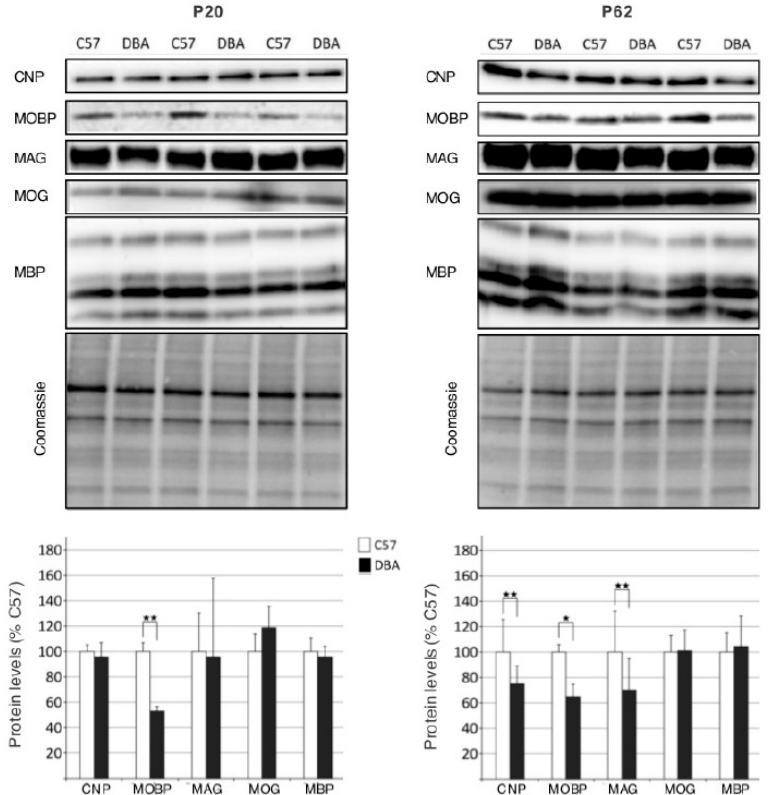
Figure 4. Di ff erences in myelin protein expression between C57 and DBA mice in whole brain extracts. Immunoblotting was performed for selected myelin proteins on whole brain extracts of P20 ( A ) and P62 (adult) mice ( B ). Coomassie staining was used for normalization to control for differences in protein. Graphs show the quantification of myelin proteins measured in pups (P20, left panel) and adult (P62, right panel) mice, respectively. Significant expression differences represented by t -test (2-tailed) ** p < 0.01; * p < 0.05. n = 3–4 mice per group.